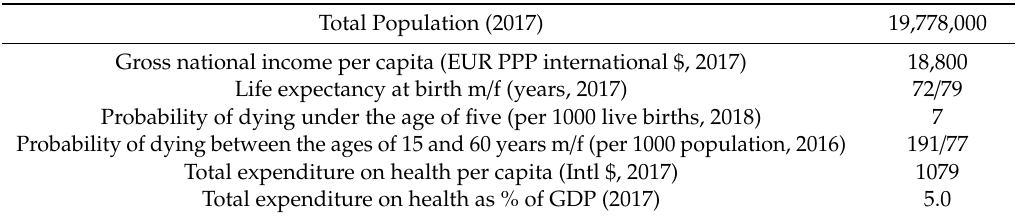
Table 1. Basic statistics of Romania [25,26].